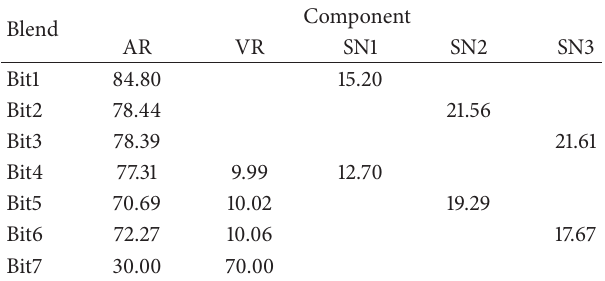
Table 1: Composition (wt.%) of the bitumen formulations.